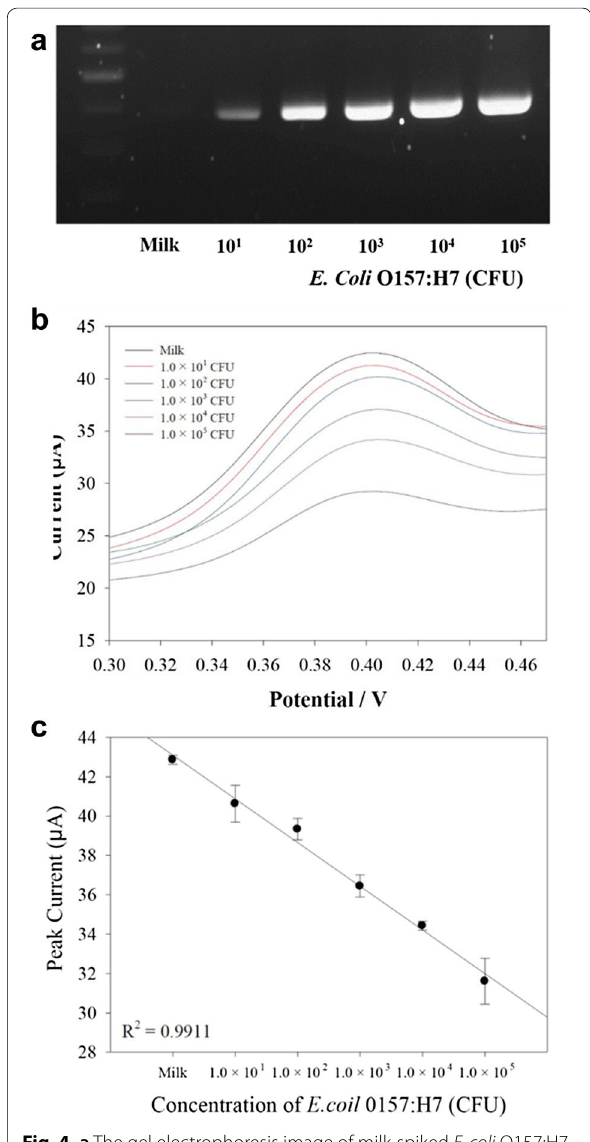
Fig. 4 a The gel electrophoresis image of milk-spiked E. coli O157:H7, b the NPE-based electrochemical responses to the milk-spiked E. coli O157:H7 concentration from 1.0 10 1 to 1.0 10 5 CFU and c the × × calibration curve. The tests were repeatedly conducted under same condition. The signal variation was presented in the error